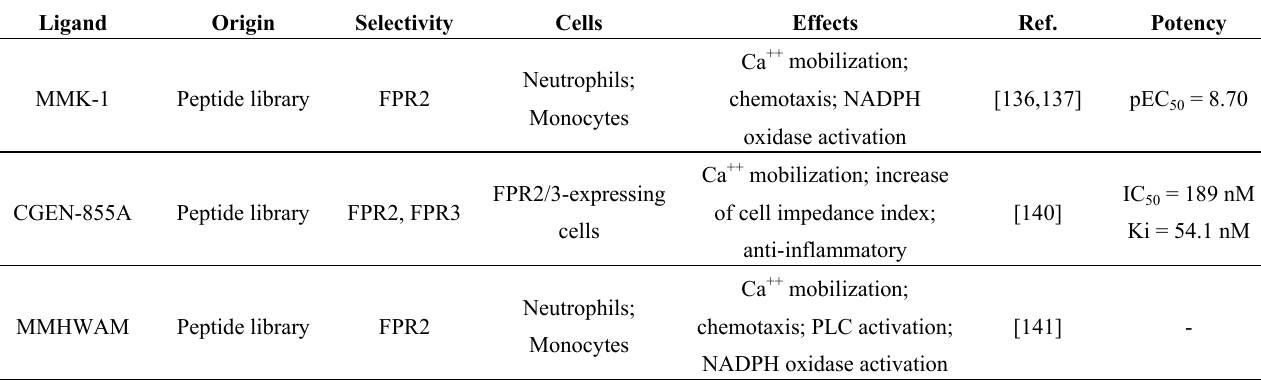
Table 9. Intracellular signaling cascades triggered by other ligands from peptide